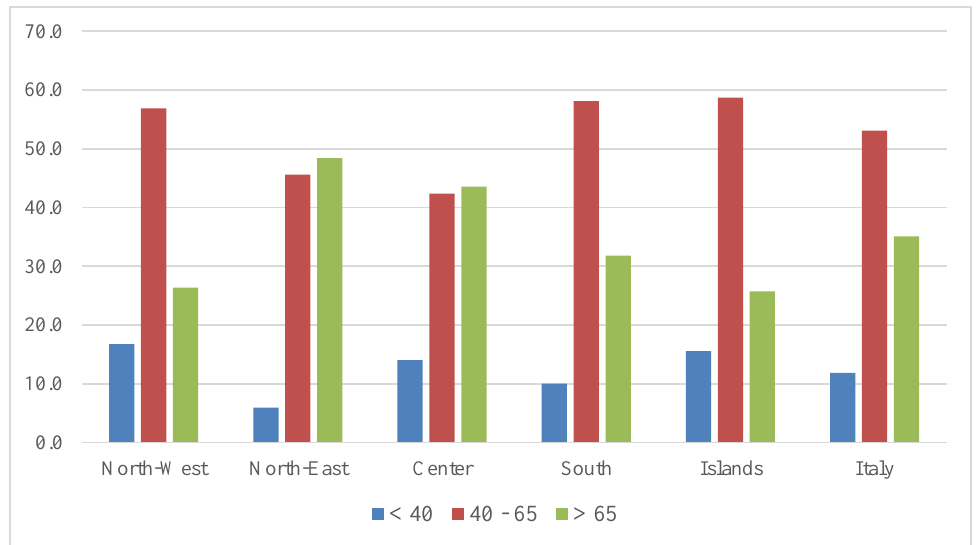
Figure 5. Percentage distribution of small farms by age group of tenants and by district. Source: Our elaboration on FADN data, 2018–2020.